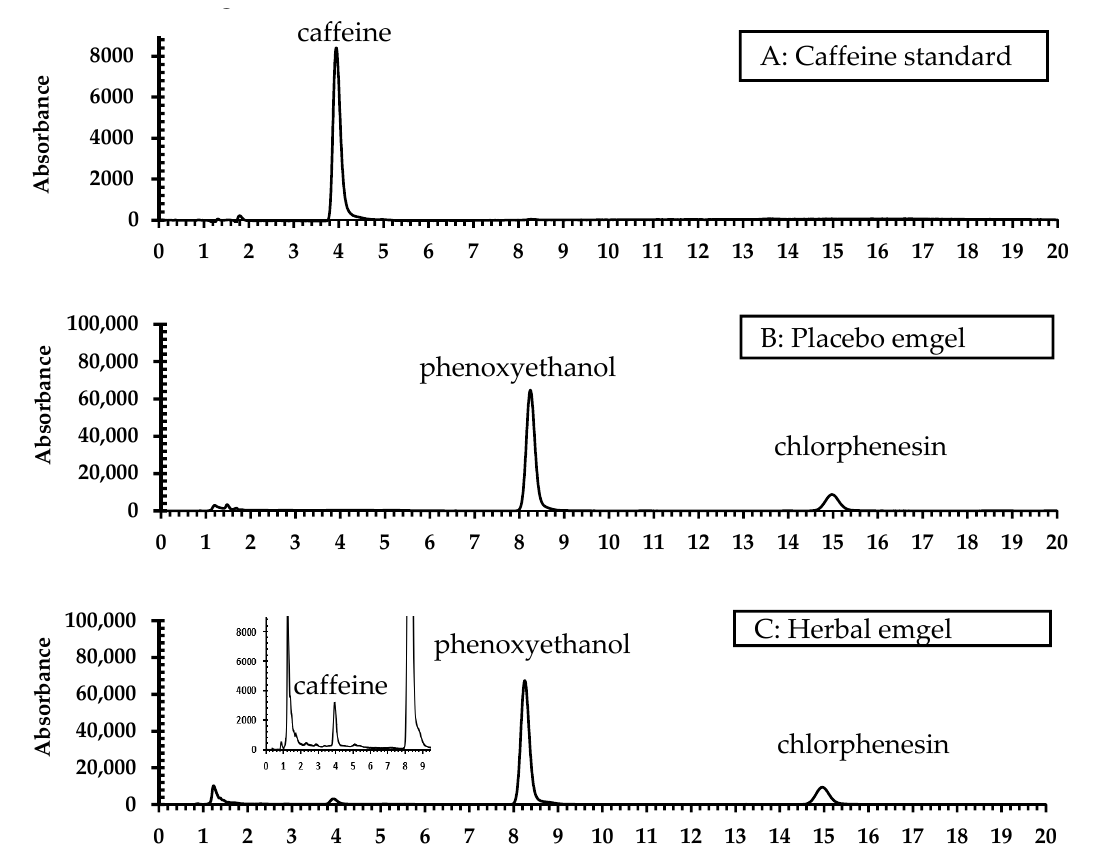
Figure 2. HPLC chromatograms of ( A ) caffeine standard (2.5 µg/mL) (RT 4.015), ( B ) placebo emgel (20 mg/mL), and ( C ) anti-cellulite emgel (20 mg/mL).